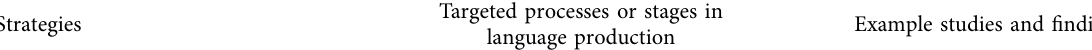
Table 1: Research studies on various stages of language production.